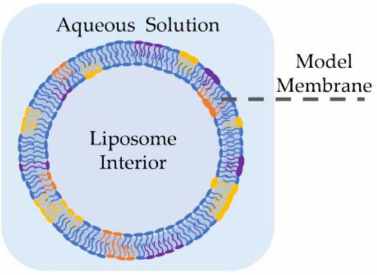
Figure 2. A cross-section of a liposome, or a lipid vesicle. Liposomes are model membranes recreating a lipid bilayer, while resembling cells in their shape and size—Especially through giant unilamellar vesicles. Liposomes can be formed through electroformation, phase transfer or microfluidic